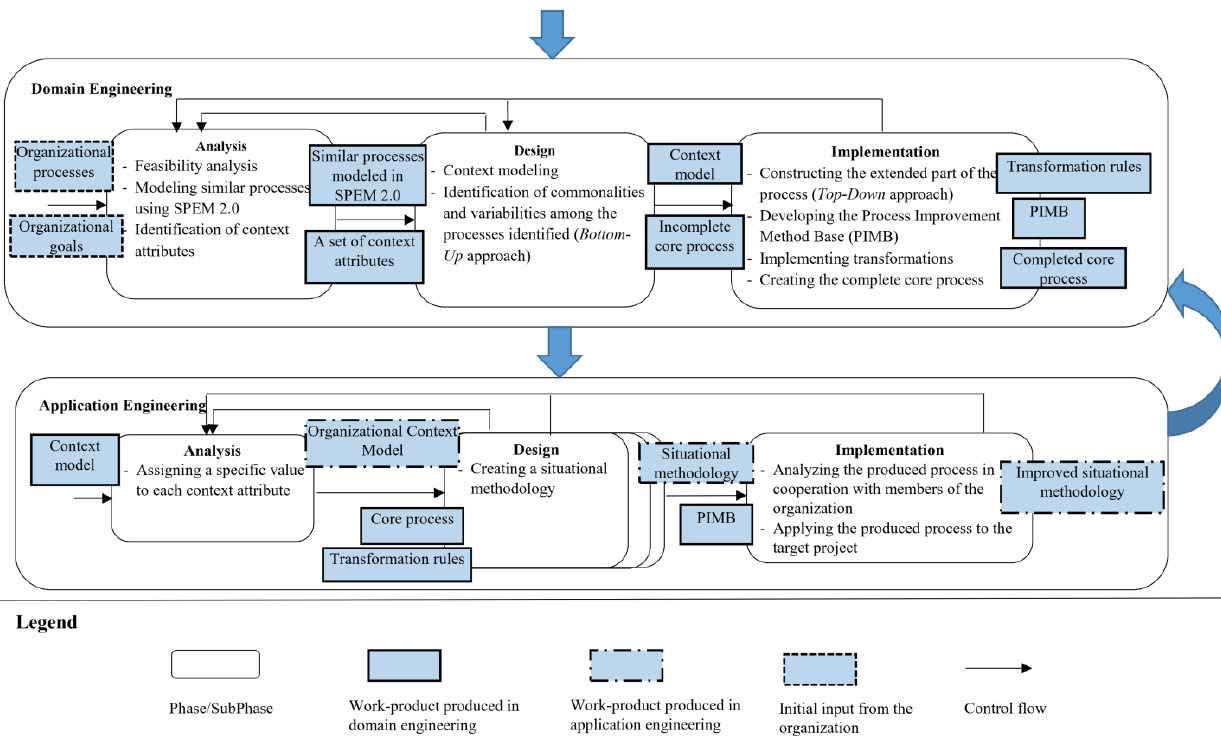
Figure 2. Proposed process for SPrLE.